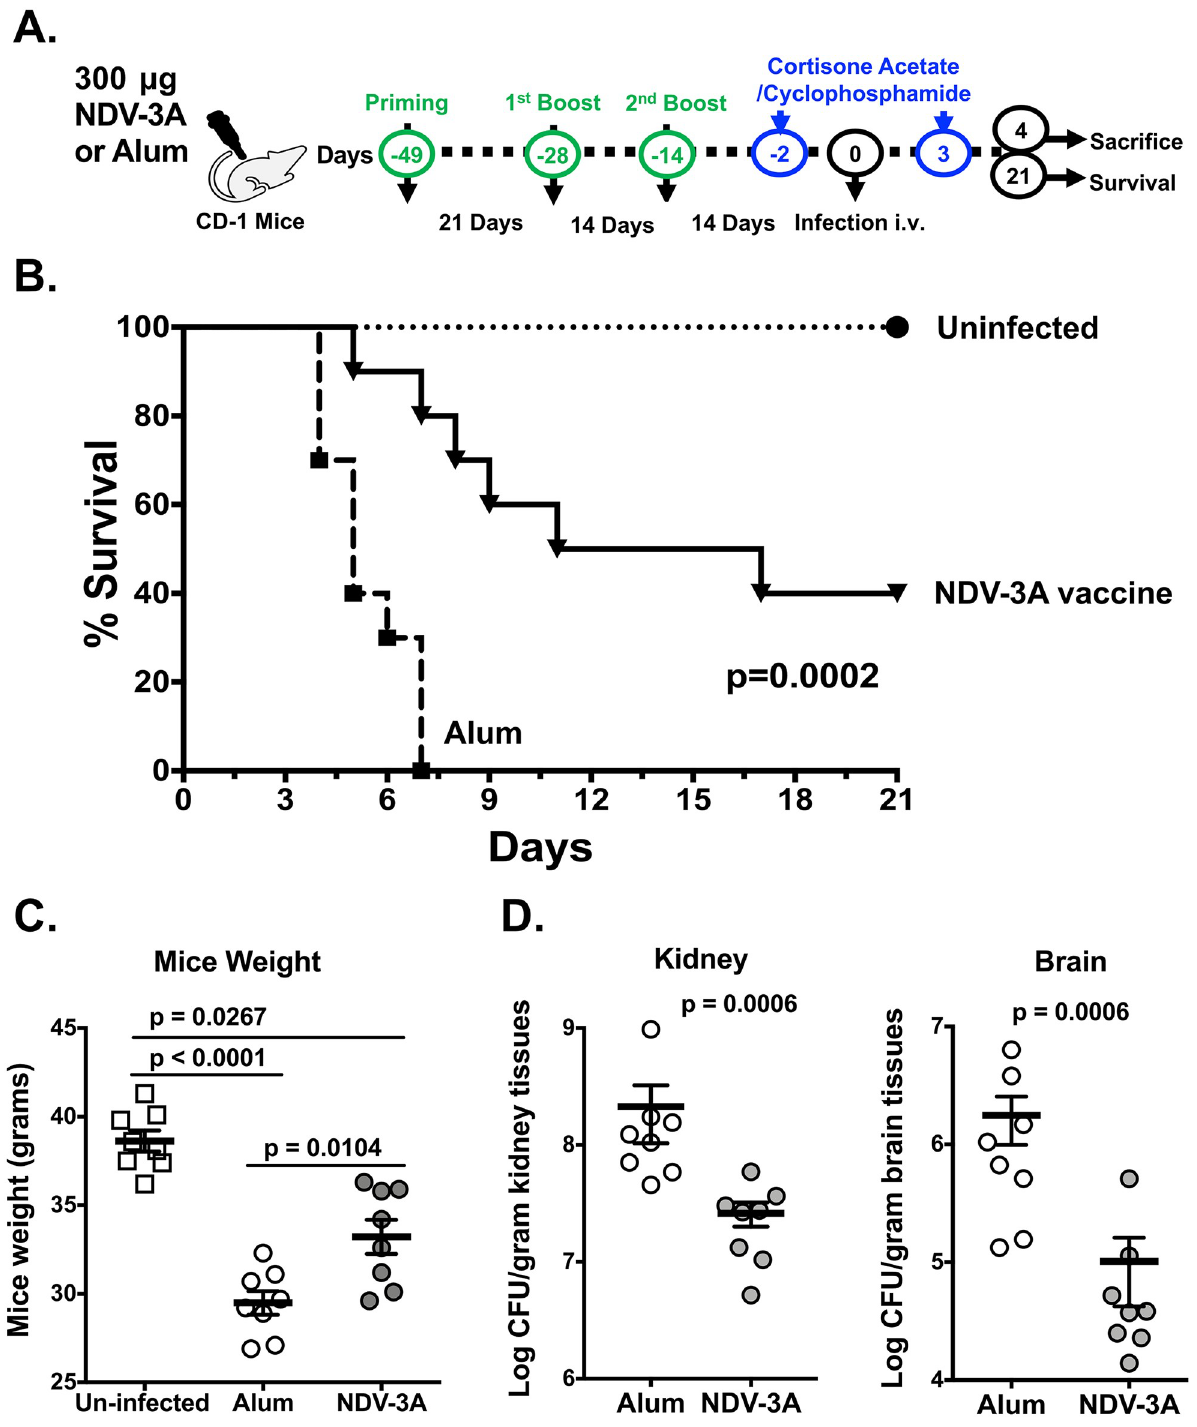
Fig 5. NDV-3A-vaccinated mice are protected from C . auris infection. (A) Outbred CD-1 mice were immunized three times with either NDV-3A or alum alone. Neutropenia was induced by two doses of cyclophosphamide and cortisone acetate on day -2 and +3 of infection. After two weeks of final boost, the mice were infected through tail vein with lethal 5x10 7 CFU/mouse dose. The mice from both groups were divided into two arms. One arm was observed for survival for 21 days, and another arm were sacrificed on day 4 post infection. (B) NDV-3A vaccinated mice were protected from C . auris disseminated infection. The mice survival was compared by using Mantel-cox Log-rank Test (n = 10 mice/group). (C) After 4 days post infection, weight of NDV-3A or alum control vaccinated mice were compared (n = 8 mice/group). (D) On day 4 post infection, NDV-3A or alum